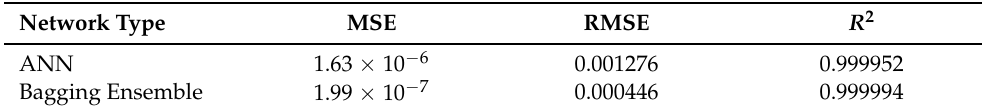
Table 6. Performance metrics: fully collateralized.